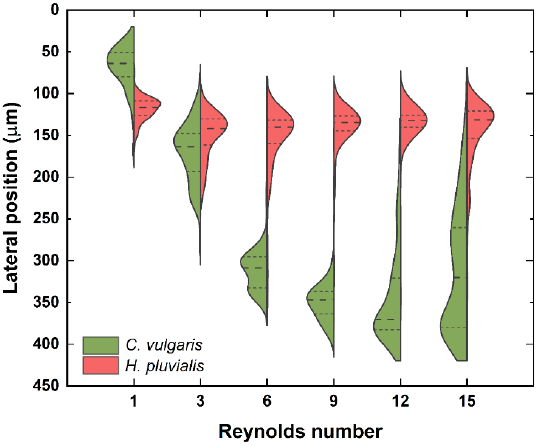
Figure 4. The lateral positions of C. vulgaris and H. pluvialis with Re ranging from 1 to 15 ( n = 100 for each alga). The dashed line and short dashed line stand for median and percentiles (25th and 75th), respectively.